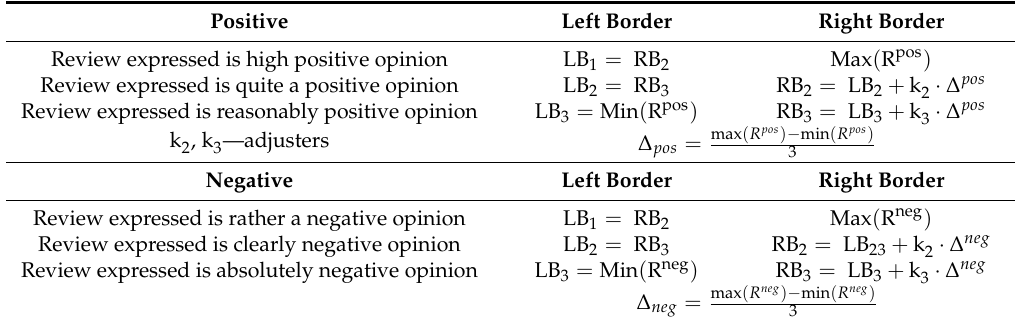
Table 15. Rules for Determining the Text Belonging to a Certain Class (Actual Classes). Positive Left Border Right Border Review expressed is high positive opinion 8 10 Review expressed is quite a positive opinion Review expressed is reasonably positive opinion 5 Negative Left Border Right Border Review expressed is rather a negative opinion 4 Review expressed is obviously negative opinion 2 3 Review expressed is absolutely negative opinion 0 1 Table 16. Empirical Rules for Determining the Text Belonging to a Certain Class (Predicted Classes). Positive Left Border Right Border